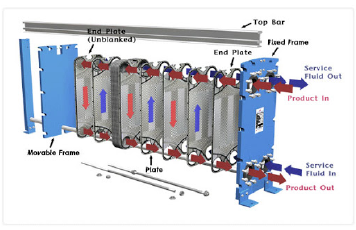
Figure 10. Plate Heat Exchanger